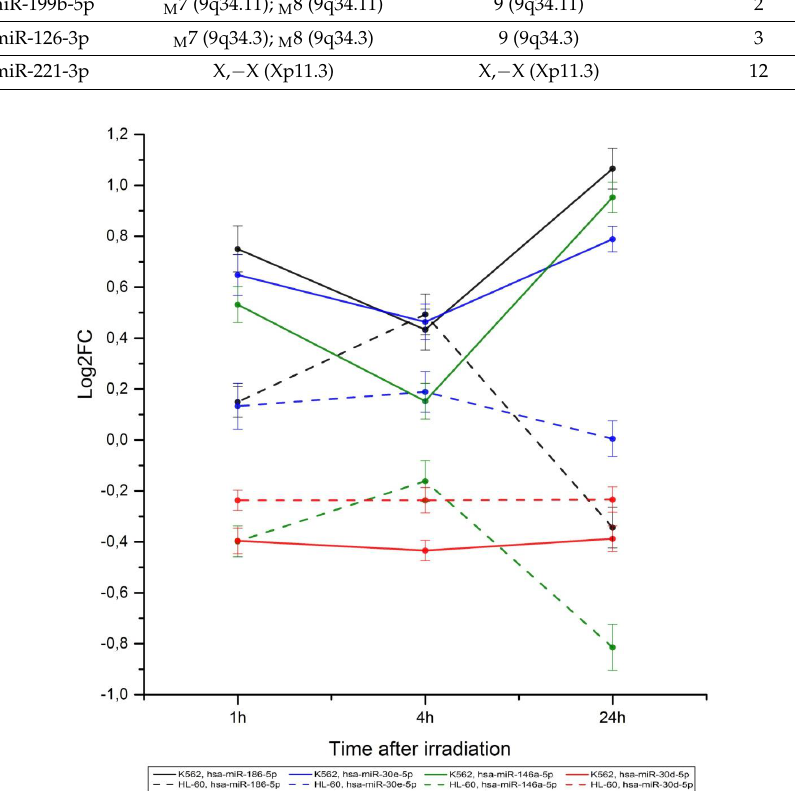
Figure 5. Comparative analysis of dynamics of the expression of microRNAs located in chromosomes with such abnormalities as trisomy and monosomy in the K562 and HL-60 cell